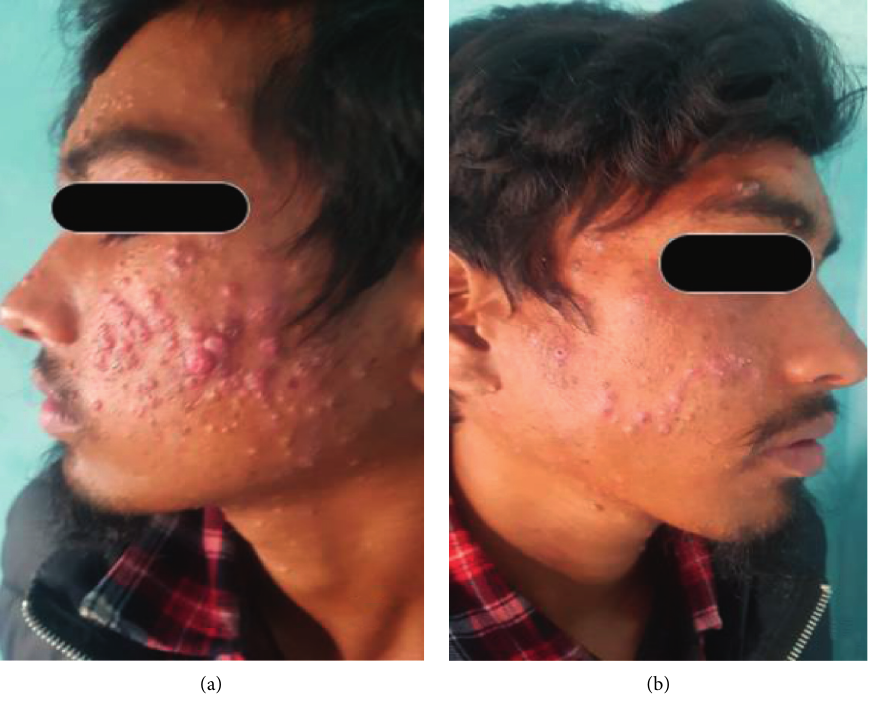
Figure 1: (a, b) MC lesions before oral